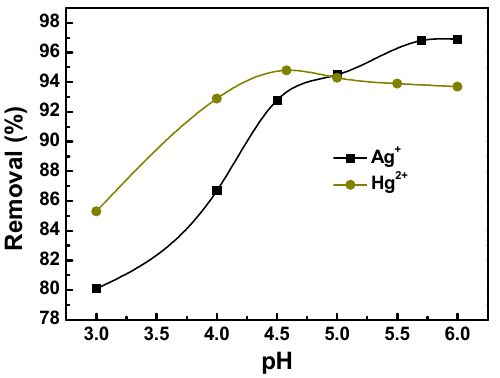
Figure 6. Effect of pH on the removal of Ag + and Hg 2+ ions onto PTT nanoparticles (initial metal concentration 200 mg·L − 1 ; adsorbent dosage 1.0 g·L − 1 ; contact time 2 h; shaking rate 200 rpm; 25 °C).